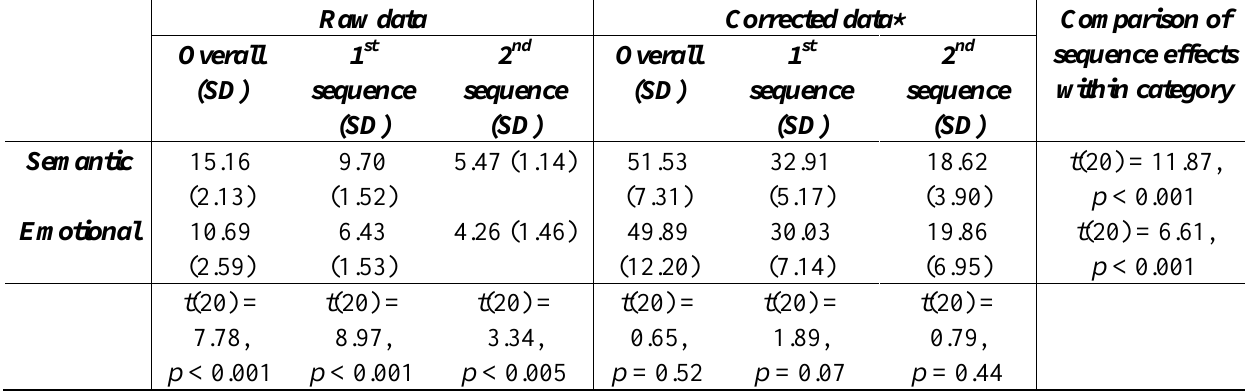
Table 3. Mean number of produced items (raw and corrected data) per category and sequence.